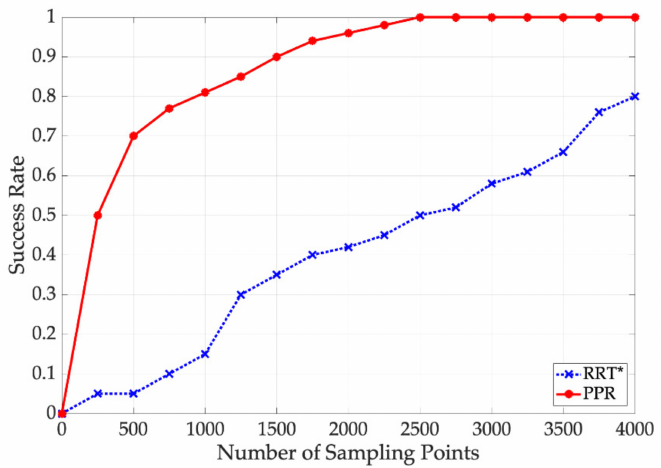
Figure 19. Success rate of the PPR algorithm and the RRT * algorithm of Case Study 1.